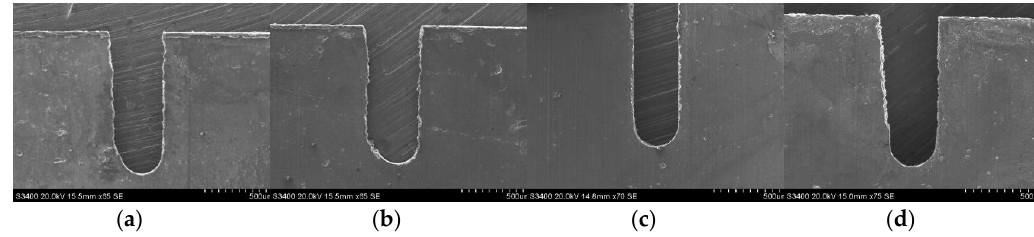
Figure 12. The slits machined by voltage feed rate combinations utilizing an electrode diameter of 0.2 mm: ( a ) 7 V–0.3 μm/s; ( b ) 7.5 V–0.5 μm/s; ( c ) 8.5 V–1.2 μm/s; ( d ) 9 V–1.2 μm/s.